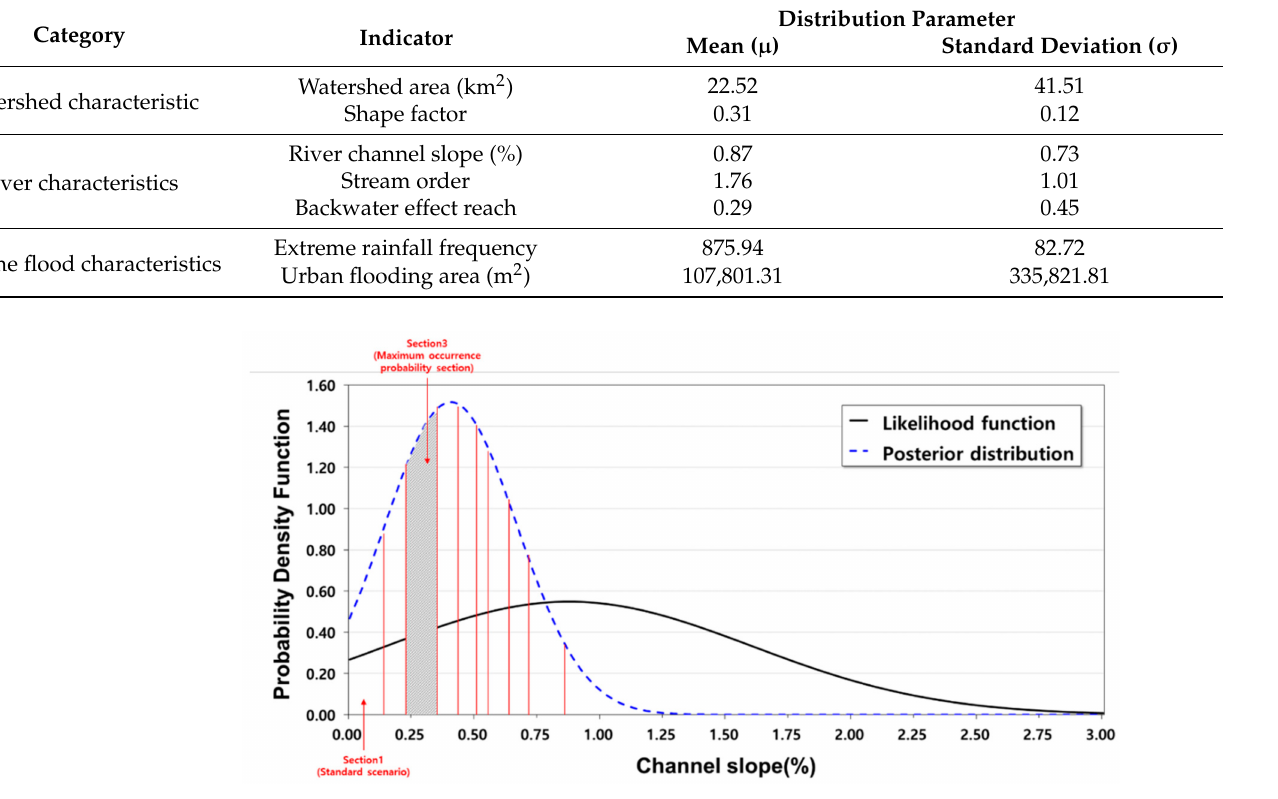
Figure 2. Likelihood function and posterior distribution of channel